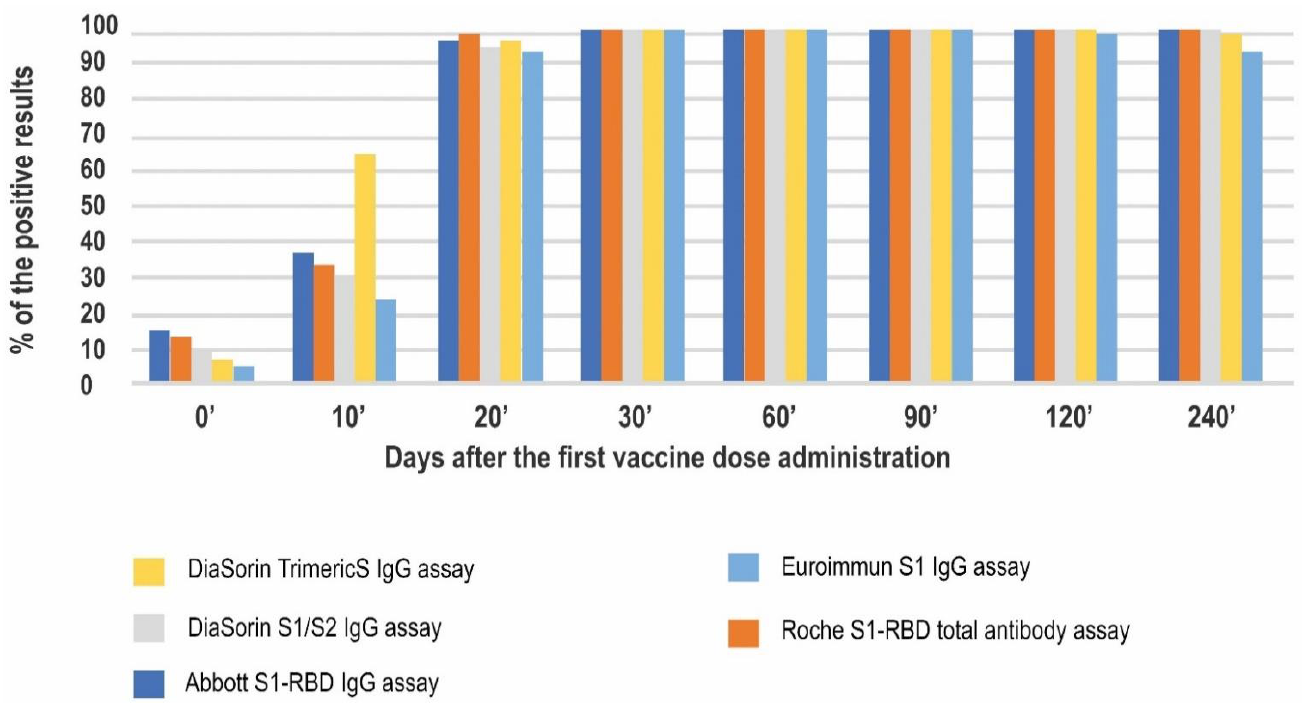
Figure 3. Seropositivity rates in 5 studied immunoassays at 8 timepoints of the study. All of the positive results observed on day 0 (cid:48) were obtained from the COVID-19 convalescents’ samples. A total of 100% and 93% of the convalescents tested positive in the Abbott’s and Roche’s tests, respectively. The lowest percentage of positive results in the convalescent group on day 0 (cid:48) was observed for Euroimmun (40%). Of interest, not one of the convalescents consistently tested positive in all of the methods used. On day 10 (cid:48) , positive results started to be noted in naïve vaccinees as well. At this timepoint, the DiaSorin TrimericS assay had the highest rate of positive results (66%.) The